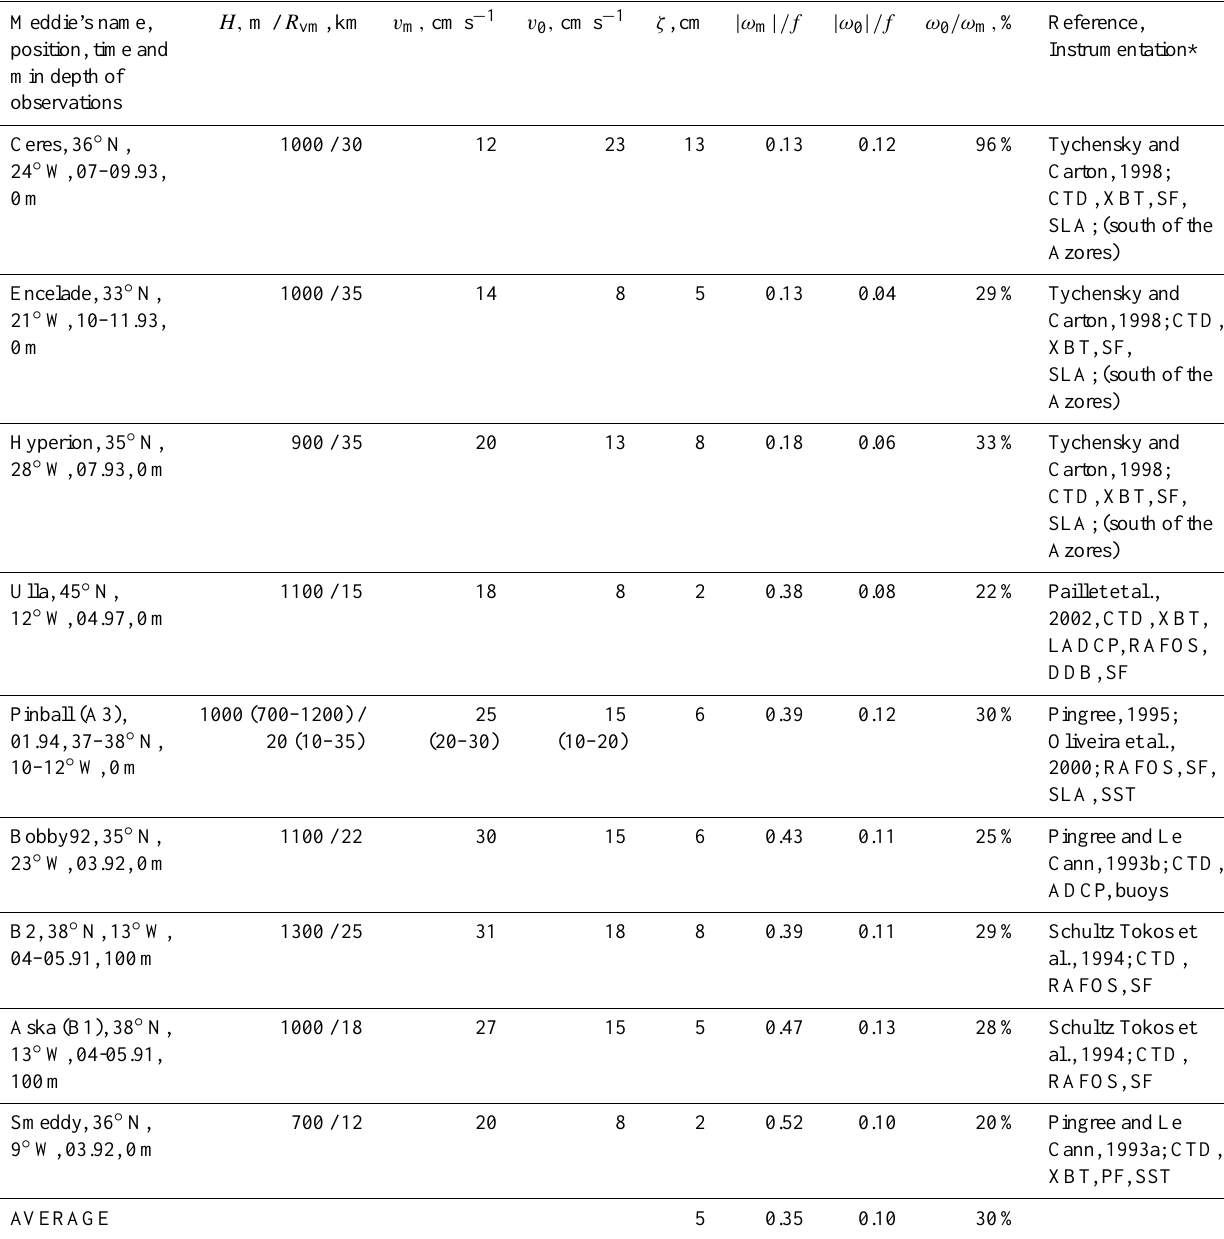
Table 1. Characteristics of surface signatures of various meddies, derived from in-situ observations; v m (ω m ) and v 0 (ω 0 ) are the maximum azimuthal velocity (vorticity) in the meddy core and in its surface signal,